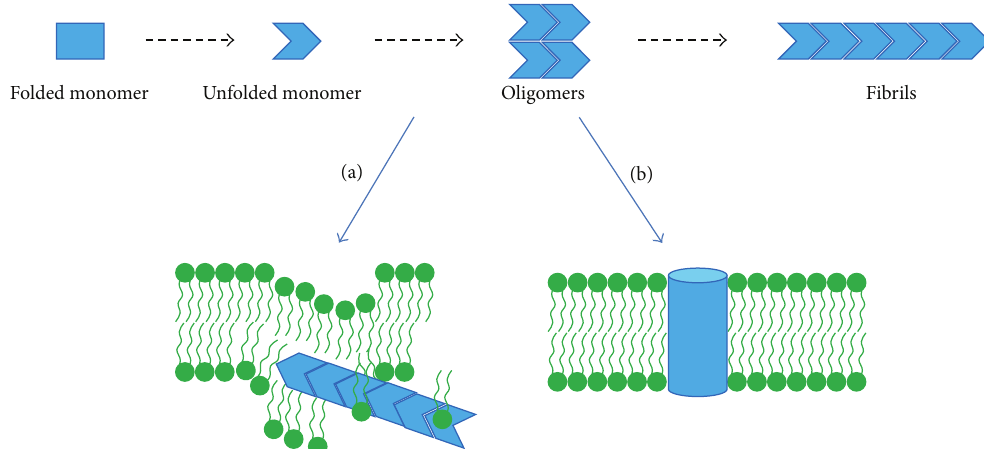
Figure 5: Schematic representation of permeabilization hypothesis. The natively fold peptide first starts to unfold. The first hypothesis (a) proposes that the monomeric peptide or small oligomers interact with the membranes and insert into the membranes. Fibril formation leads to membrane permeabilization by changes in membrane curvature and lipids recruitment. The second hypothesis (b) suggests that oligomeric species are toxic for the membrane interacting with it and forming